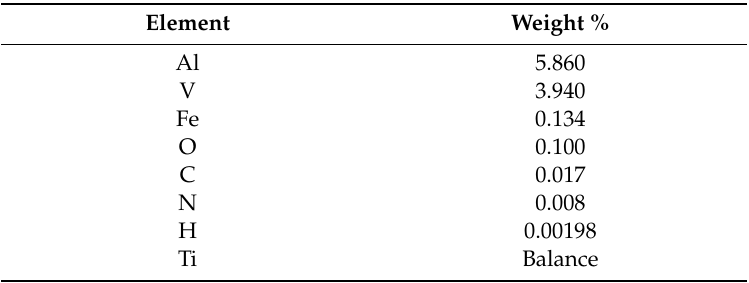
Table 1. Elemental composition of Ti6Al4V ELI (Grade 23).